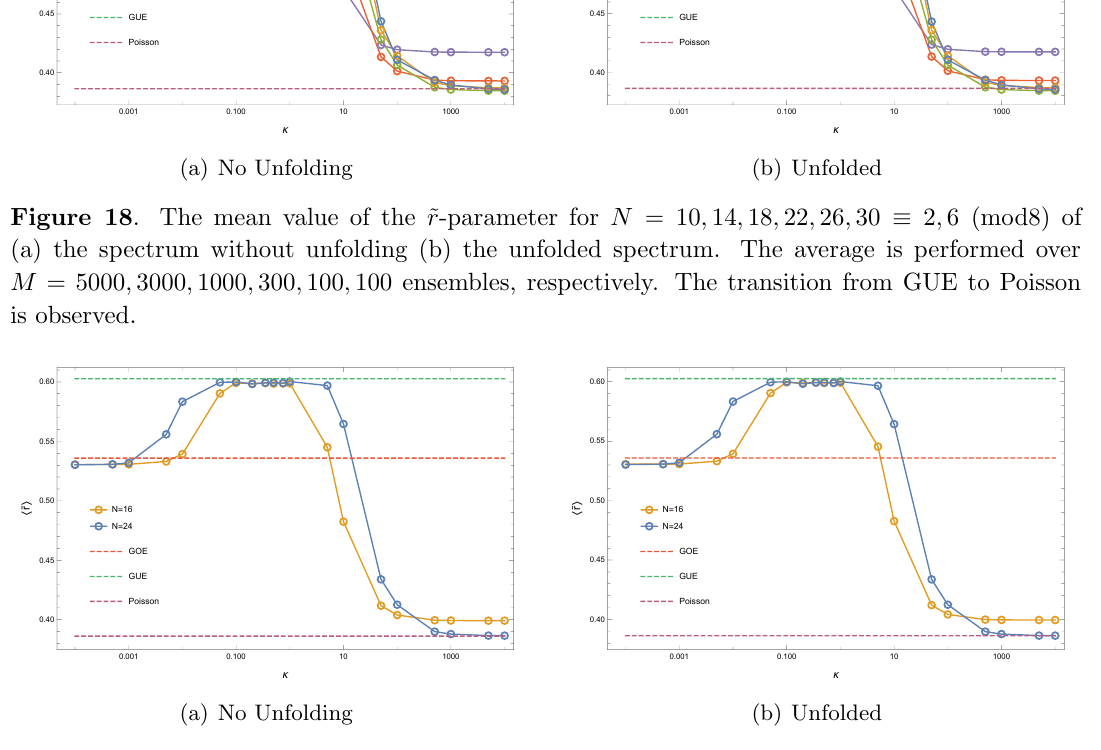
Figure 19 . The mean value of the ~ r -parameter for N = 16 ; 24 (cid:17) 0 (mod8) of (a) the spectrum without unfolding (b) the unfolded spectrum. The average is performed over M = 2000 ; 100 ensembles, respectively. We observe transitions from GOE to GUE and from GUE to